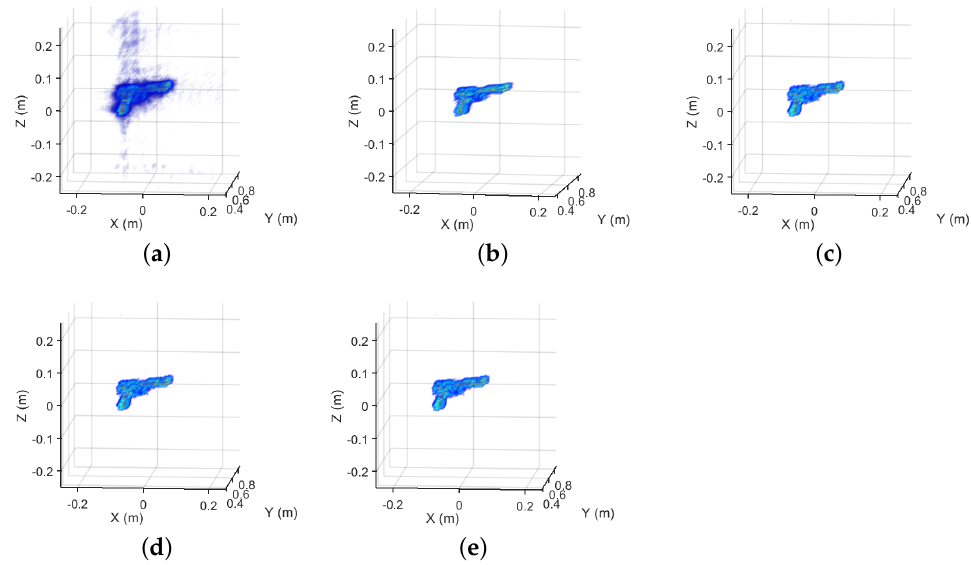
Figure 8. The imaging results of the pistol with full sampling. ( a ) The MF result. ( b ) The FIST result. ( c ) The SCAD result. ( d ) The MCP result. ( e ) The GSALSA–Cauchy